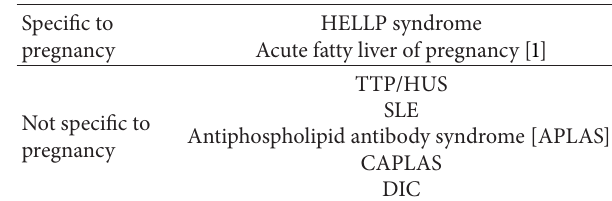
Table 1: Thrombotic microangiopathies in